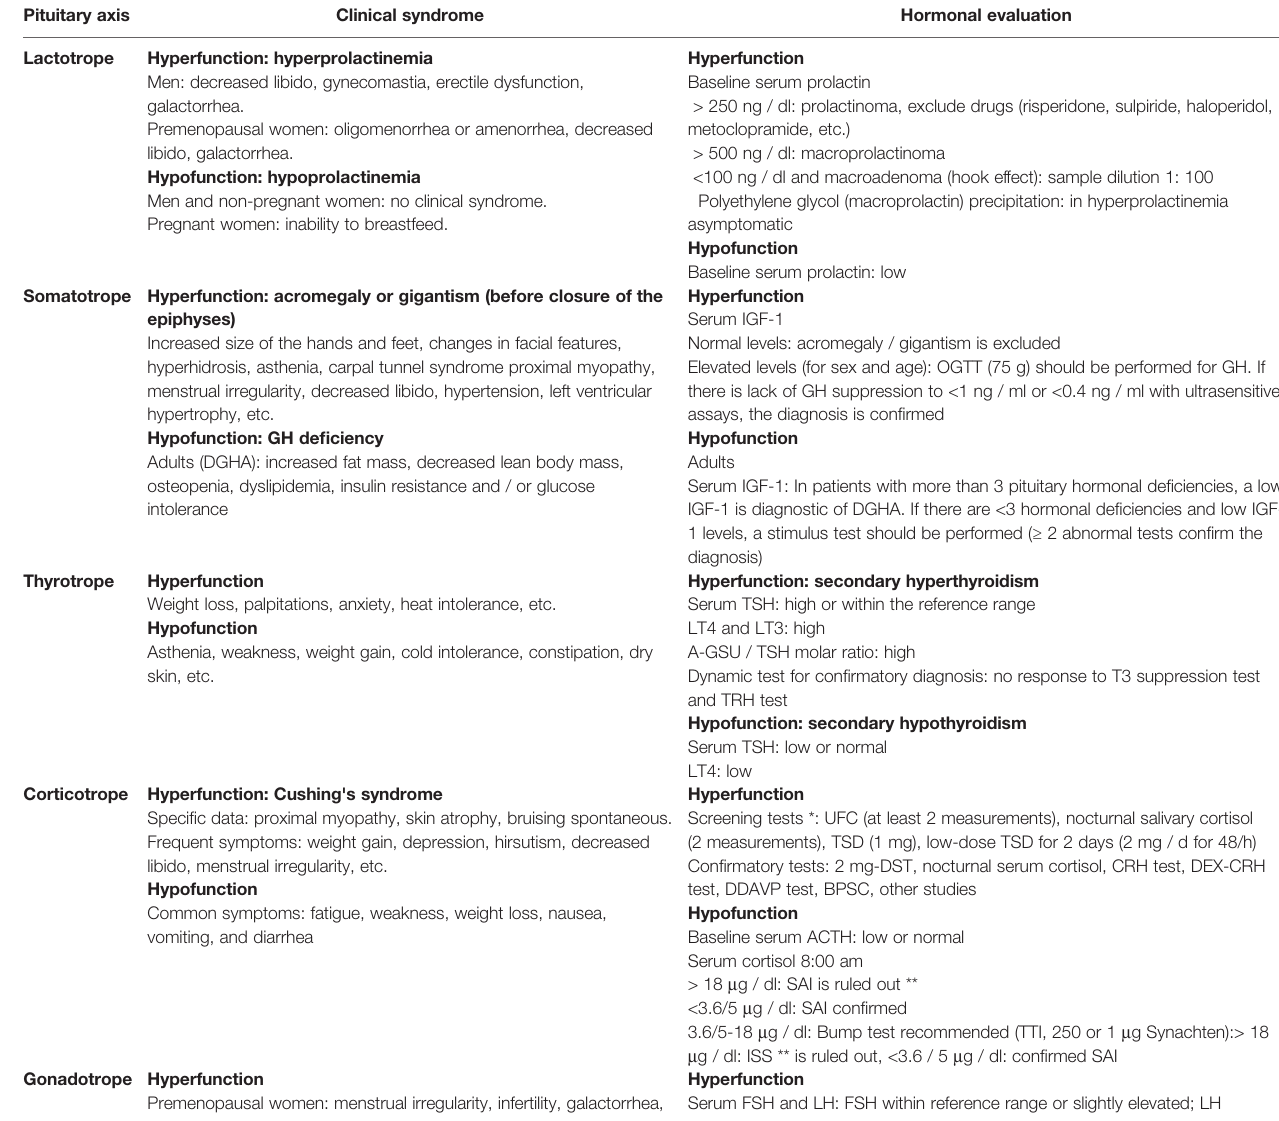
TABLE 6 | Clinical presentation and hormonal evaluation of Hypothalamic – pituitary – adrenal axis. . Pituitary axis